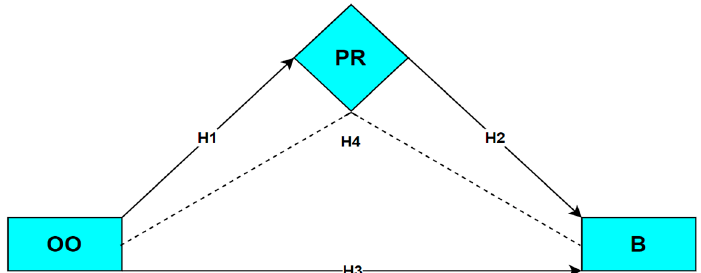
Figure 1. Hypothesized model of the relationships (PR = psychological resilience; OO = organizational ostracism; B = burnout).